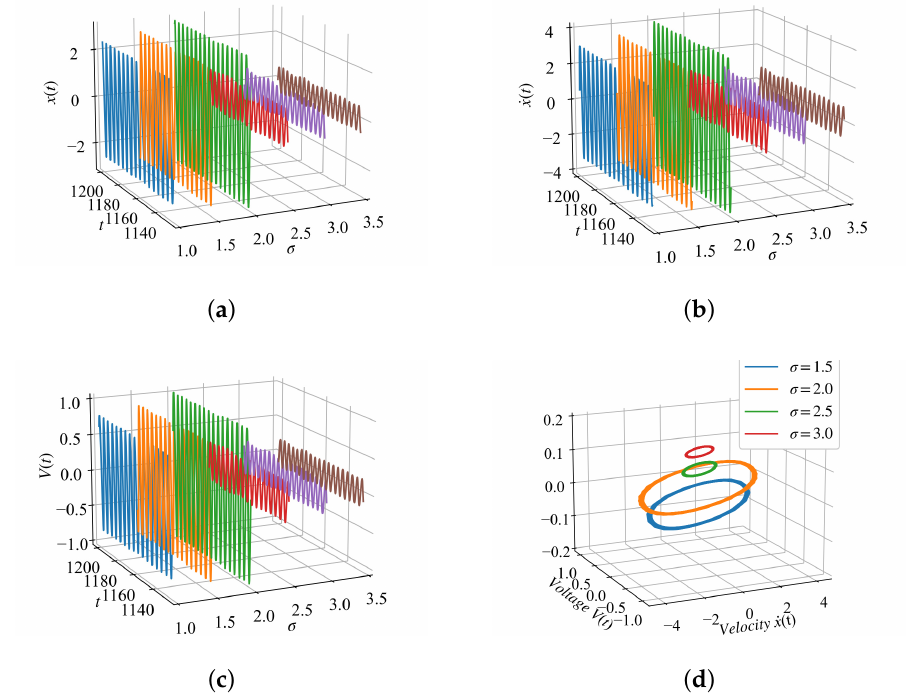
Figure 4. The response process of ( a ) displacement, ( b ) velocity and ( c ) voltage. ( d ) Phase diagram of velocity and voltage ( γ =